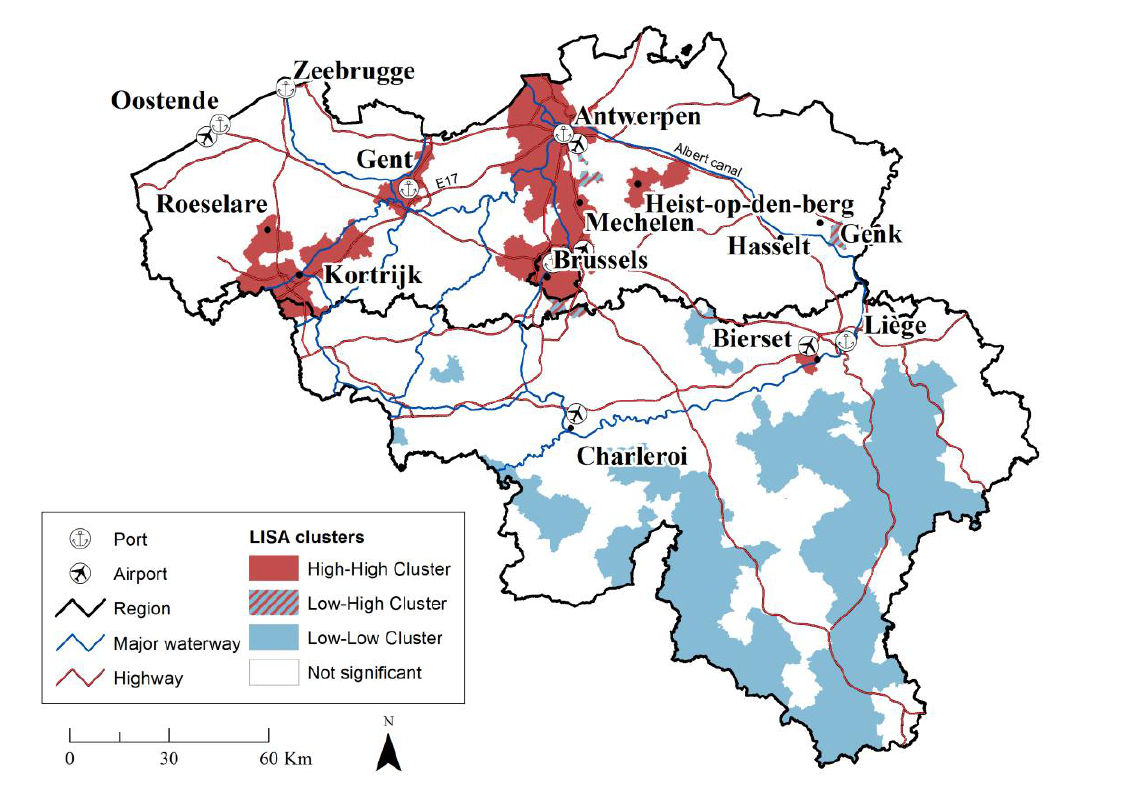
Figure 2: LISA map of employment density in logistics (contiguity spatial relation)